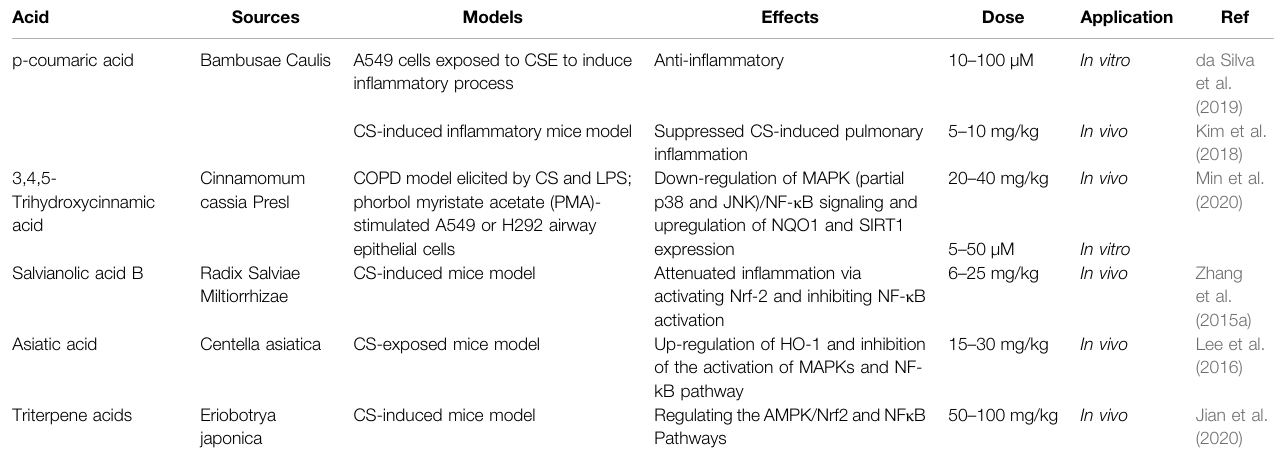
TABLE 7 | The effects of acid on